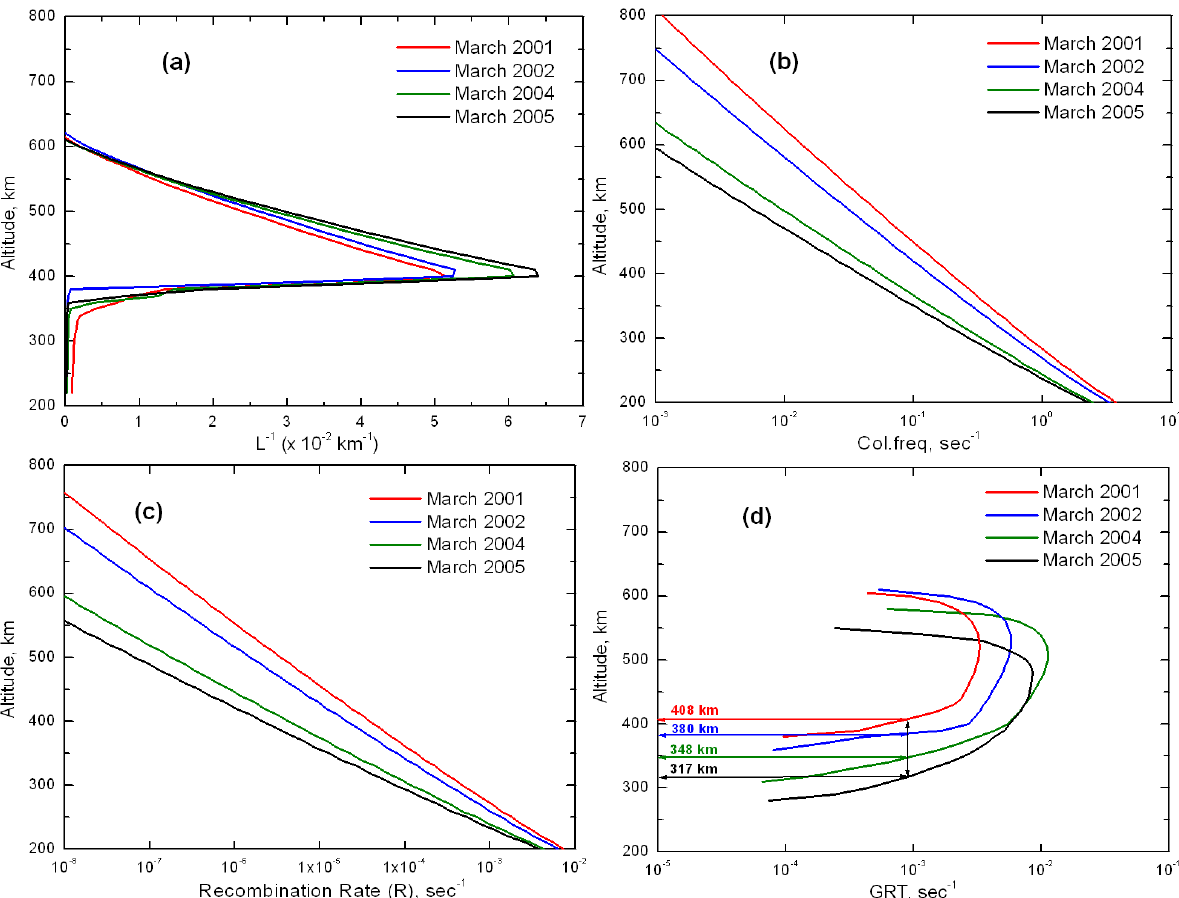
Fig. 6. Monthly mean altitudinal profiles of (a) inverse density gradient scale length, L − 1 , (b) ion-neutral collision frequency, ν in , (c) recombination rate, R , and (d) the local linear growth rate of collisional Rayleigh-Taylor instability γ for the months of March 2001 (red), 2002 (blue), 2004 (green) and 2005